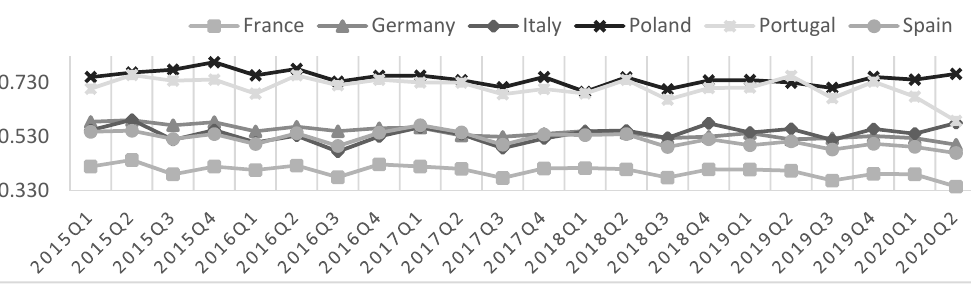
Figure 6. Import intensity coefficient of private investment, own work, source: Eurostat.